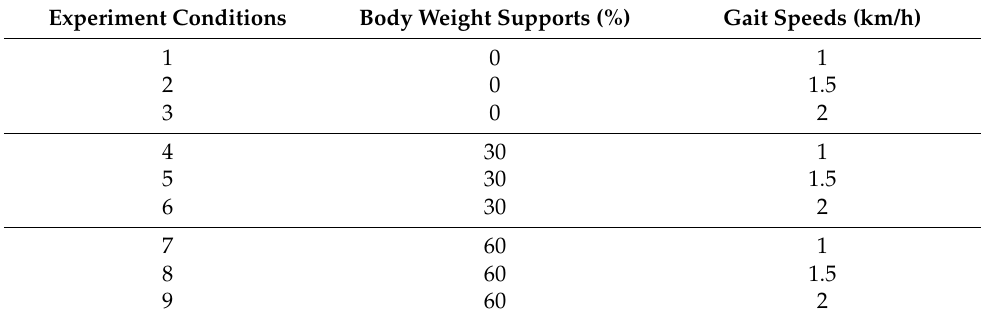
Table 2. Experiment settings according to the gait speed and body weight